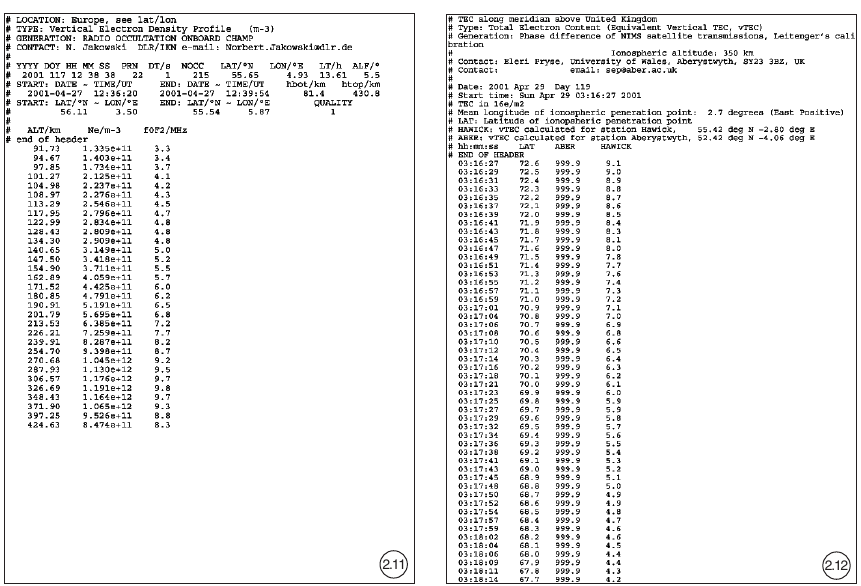
Fig. 2.11. Vertical electron density profile from the CHAMP space craft, extracted from the TECEDA database. Fig. 2.12. TEC time series from NIMS satellite transmissions, extracted from the TECEDA database.